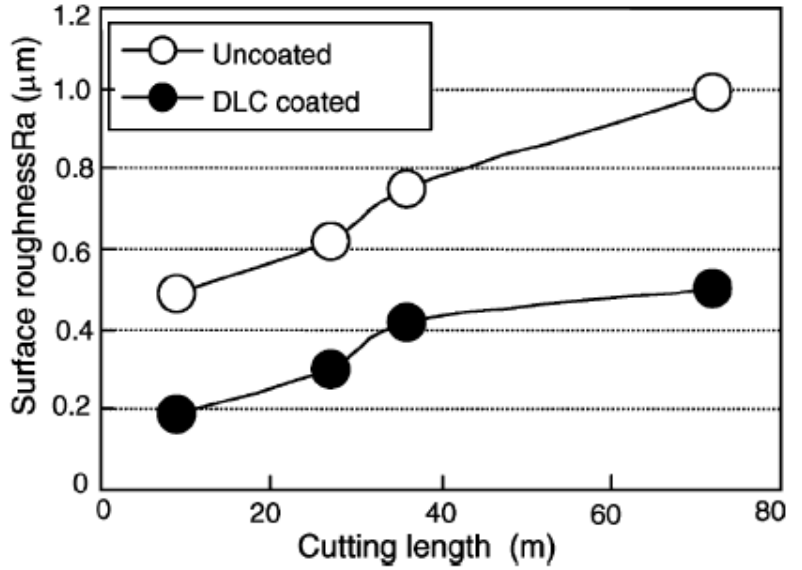
Figure 8. The variation of the surface roughness with along the cutting length [71].